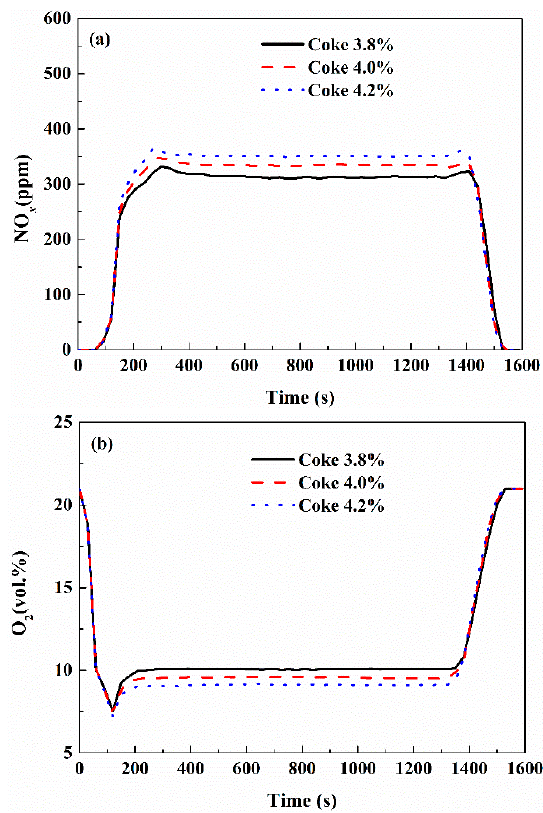
Figure 10. NO emissions ( a ) and O 2 contents ( b ) of flue gas with different coke ratios.